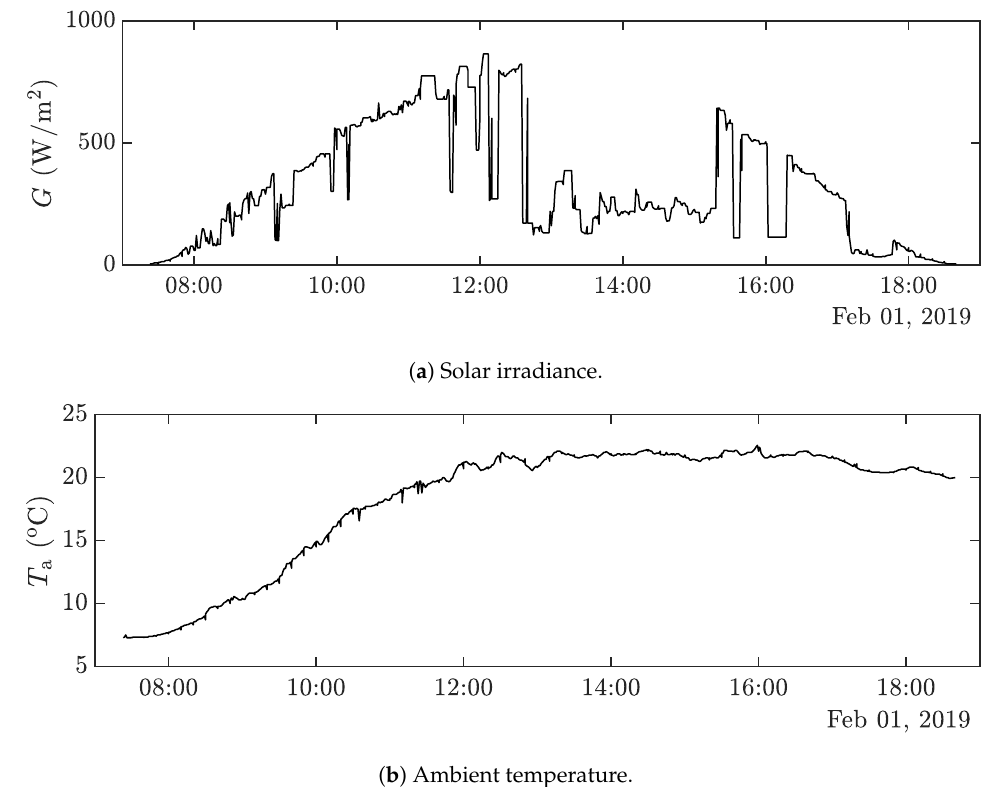
Figure 7. Weather measurements station for the case